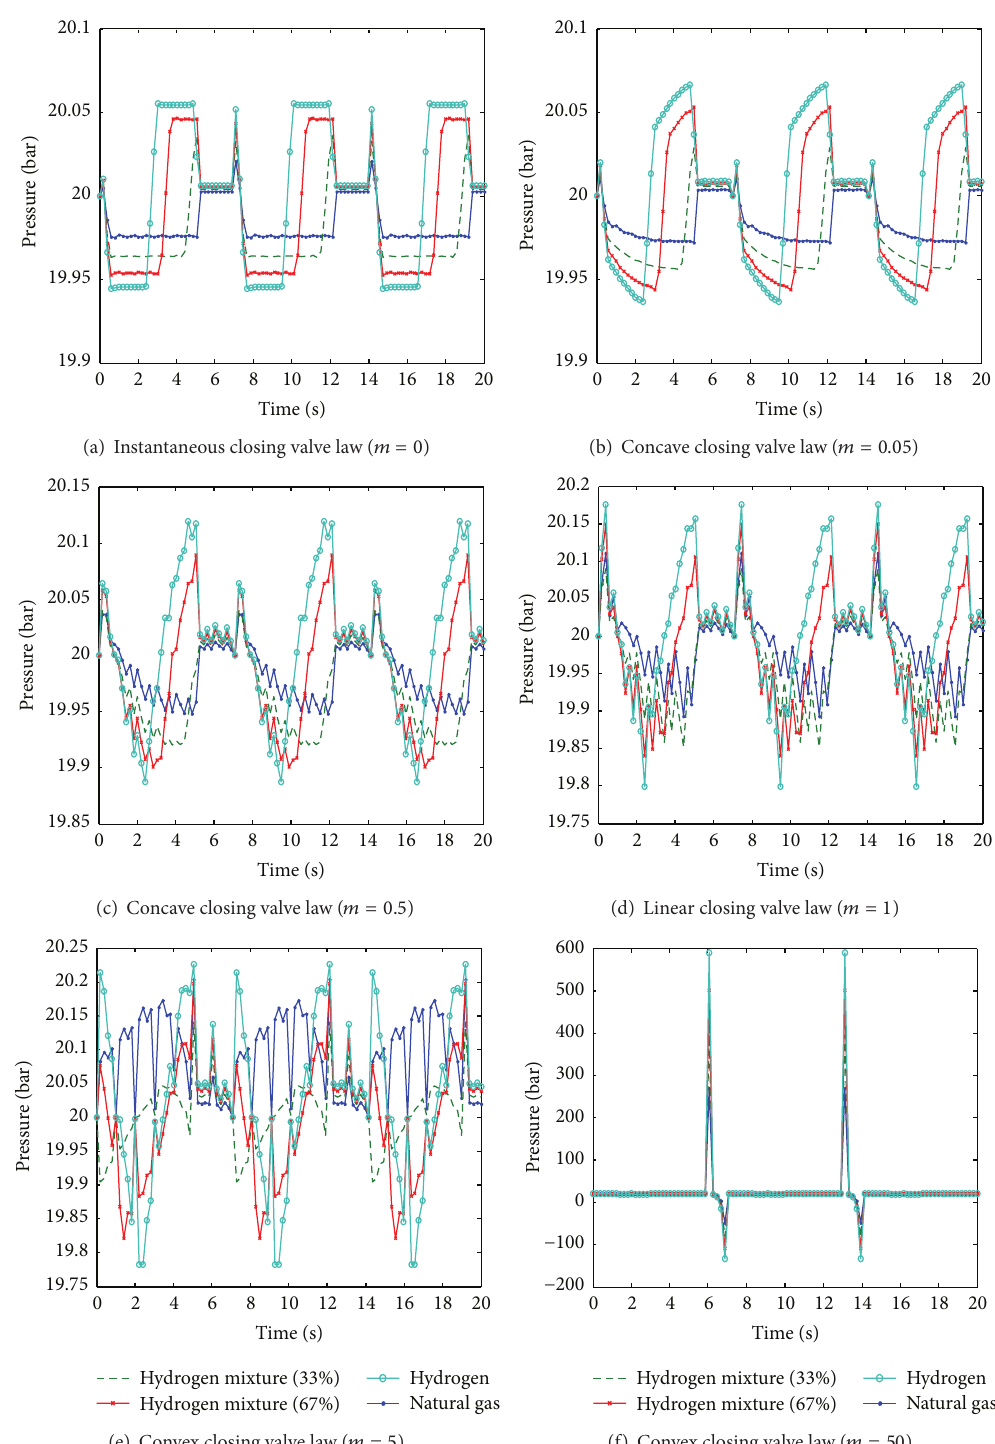
(f) Convex closing valve law ( 𝑚 = 50 ) Figure 4: Transient pressure waves for different types of closing valve laws at different mass